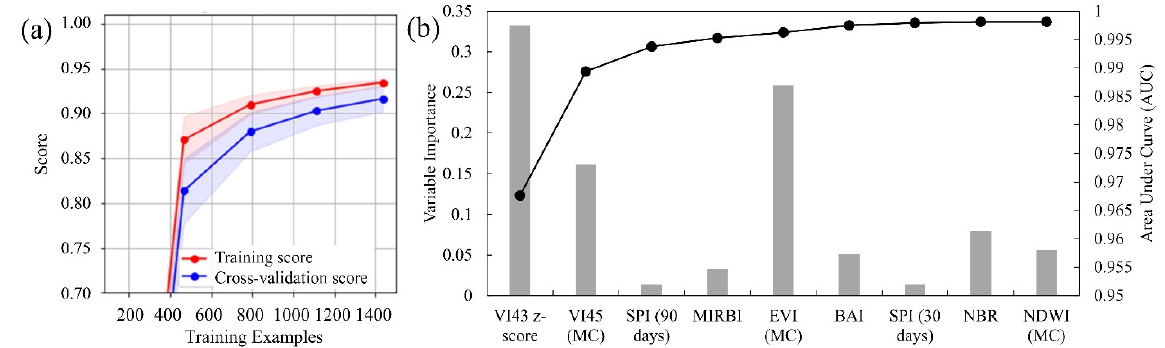
Figure 5. ( a ) Impact of training point count on model score (i.e., overall accuracy) using cross-validation (100 iterations, 20% randomly selected each time as validation set); shaded area shows ± 1 standard deviation. ( b ) Variable importance values using permutation importance and the contribution of each variable to the AUC for the Random Forest model. VI43 = vegetation index (VI) near infrared (NIR)–red ratio, VI45 = NIR–Shortwave infrared (SWIR) 1 ratio, SPI = Standardized Precipitation Index, MIRBI = Mid InfraRed Burn Index, EVI = Enhanced Vegetation Index, MC = change from monthly mean, BAI = Burned Area Index, NBR = Normalized Burn Ratio, NDWI = Normalized Difference Wetness Index.